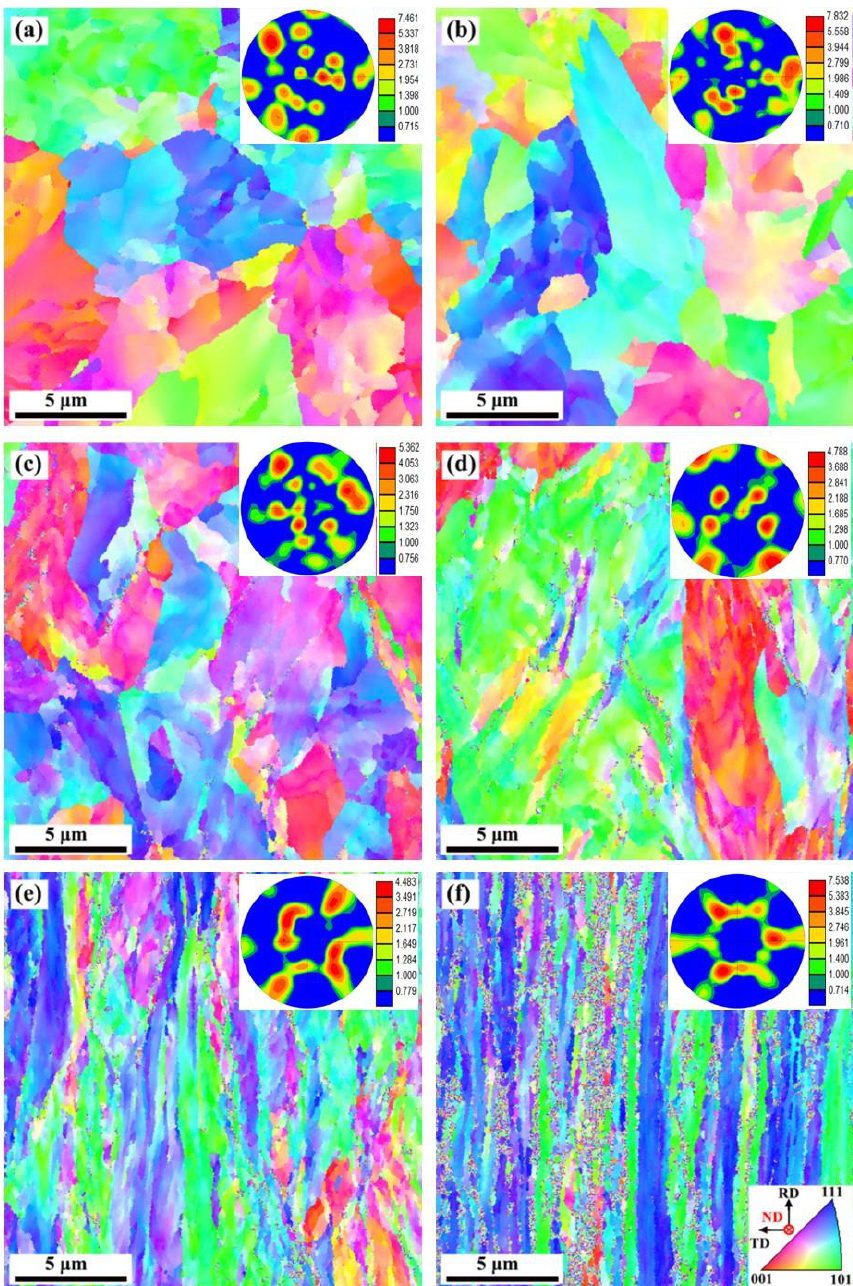
Figure 4. EBSD orientation maps of the rolling direction-transverse direction (RD-TD) planes of the SK85 steel before rolling ( a ) and at a rolling reduction of ( b ) 10%; ( c ) 30%; ( d ) 50%; ( e ) 70%; and ( f ) 90%. The insets are the corresponding {001} pole figures, and {001} is perpendicular to the normal direction (ND). Figure 5 is the color-coded high-resolution KAM distribution maps of the SK85 steel before and after cold rolling. The bar of blue to red pixels in the KAM maps corresponds to the increasing angles from 0 to 5 ◦ . The heterogeneous KAM angles show the deformation induced local orientation gradients inside the ferrites. The larger KAM angles correspond to a higher dislocation density. As clearly shown in the KAM maps, the local plastic strain gradually accumulated and was particularly obvious above a reduction ratio of